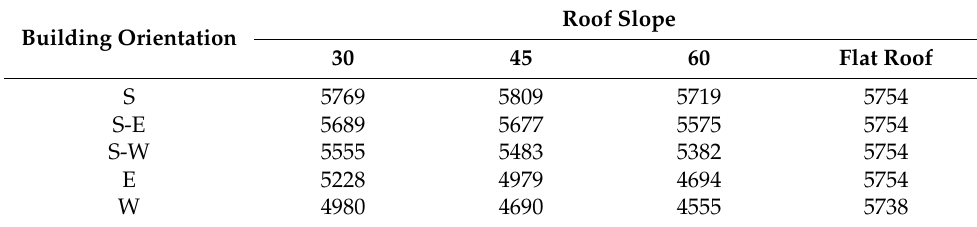
Figure 6. Statistical NPV values on a macroeconomic level depending on roof inclination. Table 3. The mean NPV value on a macroeconomic level, depending on the orientation and inclination of the roof